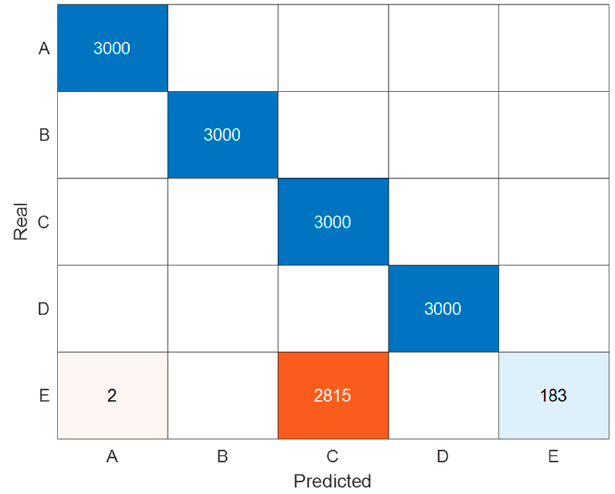
Figure 10. Confusion matrix of AP-CNN ( − 10 dB).